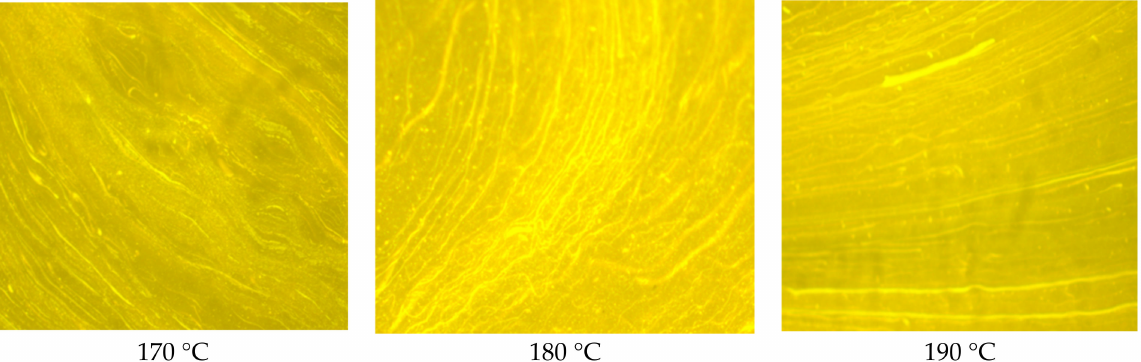
Figure 5. Fluorescence microscopy test of SBS-modified asphalt at different shear temperatures (100 times).